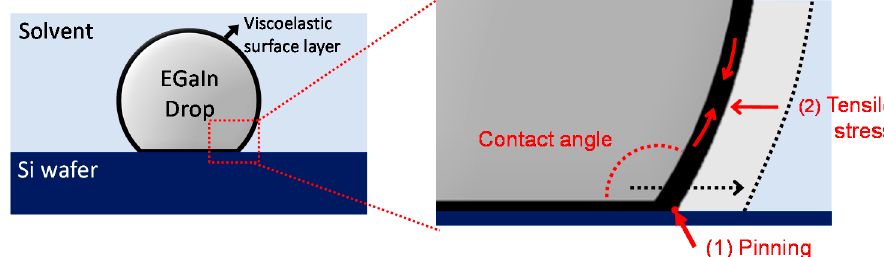
Figure 2. Schematic of the contact angle of the EGaIn droplet placed on a Si wafer. The viscoelastic surface layer (1) pins the metal to the substrate and (2) withstands the tensile stress.